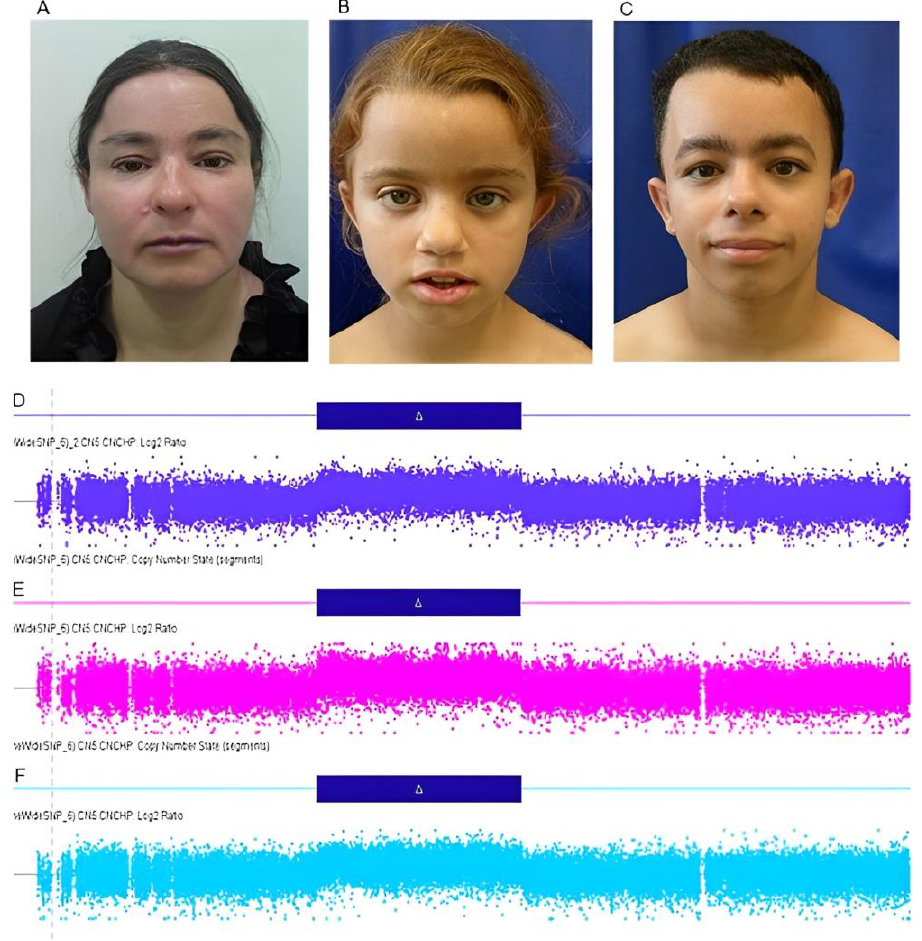
Figure 2. ( A – C ) Affected individuals harboring the unbalanced rearrangement, with a 19.3 Mb duplication of the q21.1q22.31 region of chromosome 15, with facial dysmorphisms: discrete syn- ophrys, upslanted palpebral fissure, low-set ears, bifid nasal tip, downturned corners of mouth, and retrognathia. Subject 1 (III-4) ( A ), subject 2 (IV-11) ( B ), and subject 4 (IV-15) ( C ). ( D – F ) Log2ratio